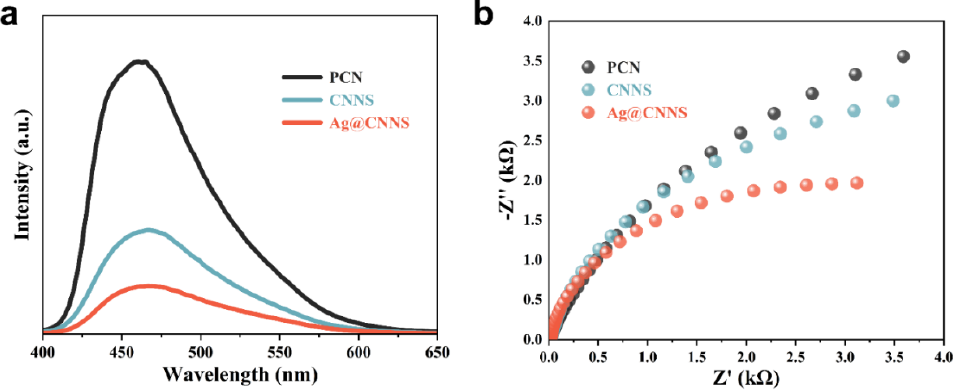
Figure 3. ( a ) PL spectra and ( b ) EIS Nyquist plots of PCN, CNNS, and